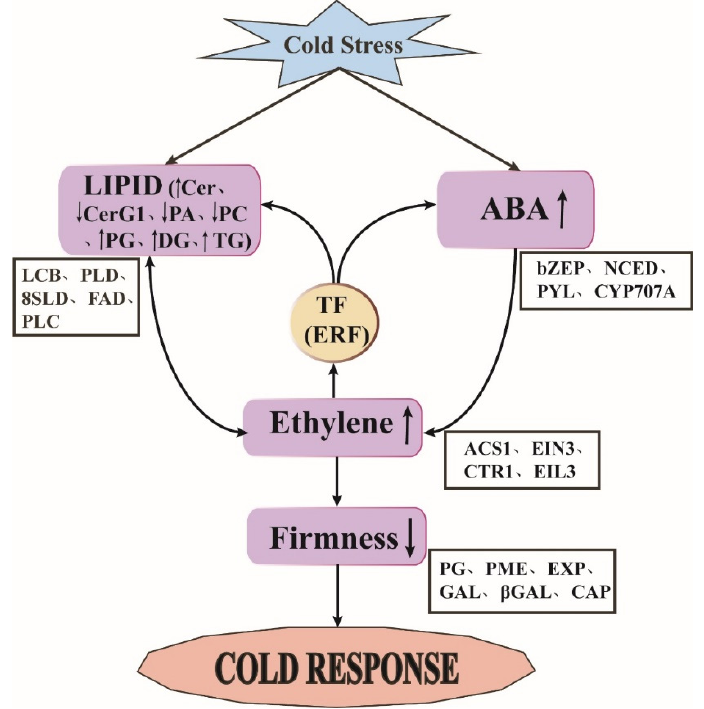
Figure 9. Regulatory model of DEGs involved in pathways related to TFs, phytohormones, cell wall structure, and lipids during cold storage. Arrows indicate changes in ethylene content, lipid content, and fruit firmness.